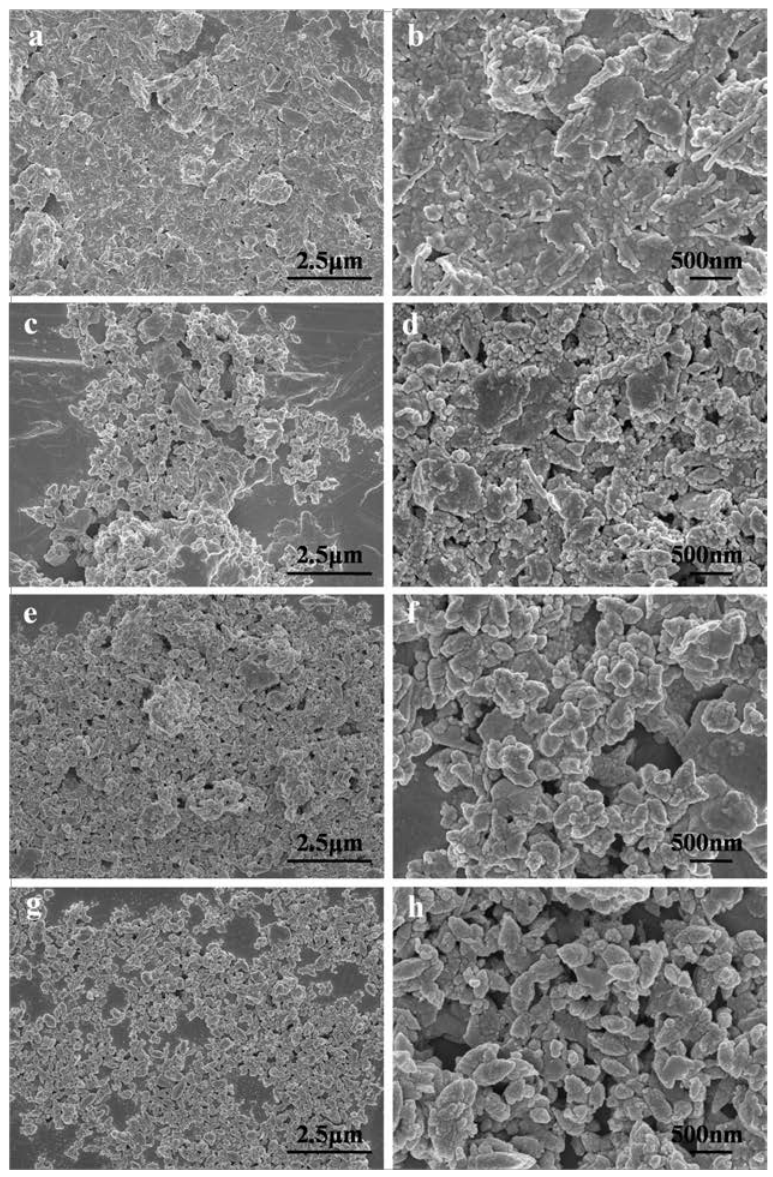
Figure 3. Field emission scanning electron microscopy (FE-SEM) images of ( a, b ) PAL, ( c, d ) ZnO/PAL, ( e, f ) ZnO/PAL-1 and ( g, h ) ZnO/PAL-2.